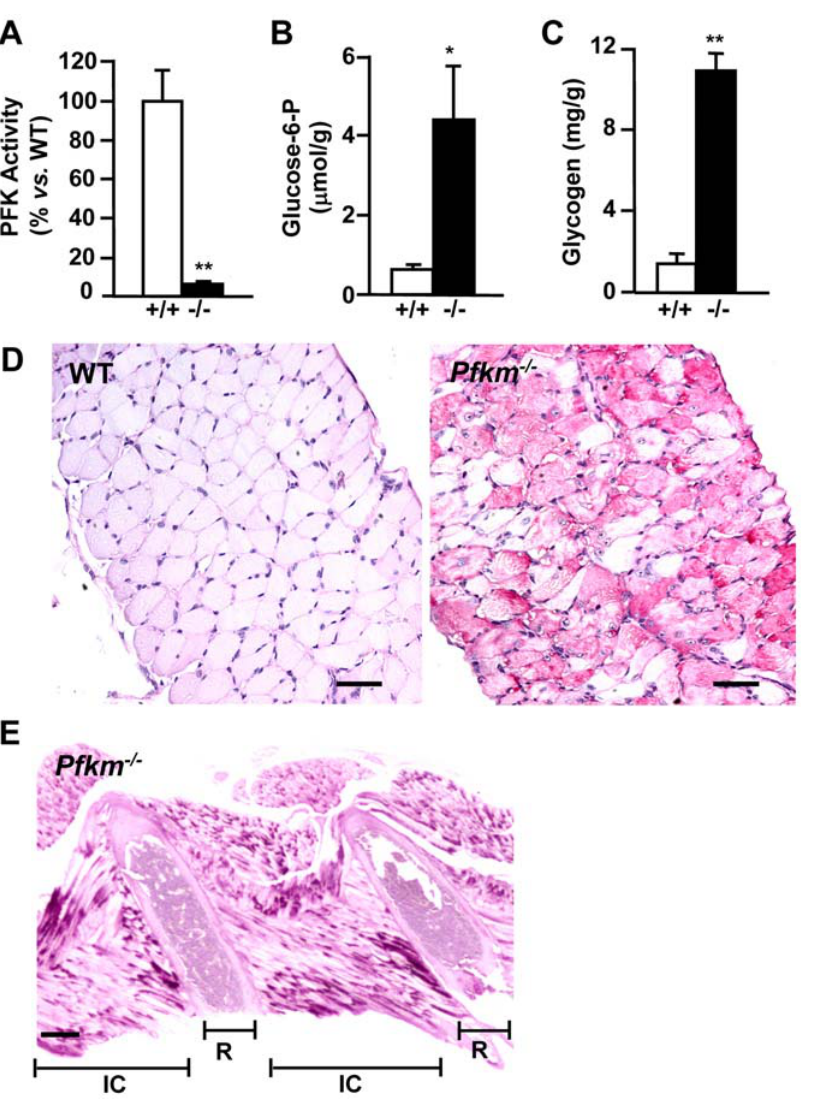
Figure 4. Effect of Pfkm ablation in diaphragm glucose metabolism and in respiratory muscle glycogen storage. (A) PFK activity was determined in diaphragm extracts as indicated in Materials and Methods. Basal PFK activity in wild-type mice was 26.5 6 4.2 U/g tissue. (B,C) Glucose- 6-phosphate (B) and glycogen concentrations (C) were determined in diaphragm perchloric extracts from wild-type ( + / + ) and Pfkm 2 / 2 ( 2 / 2 ) mice, as indicated in Materials and Methods. Results are mean 6 SEM of five mice per group. * P , 0.05, ** P , 0.01 vs. wild-type. (D,E) Glycogen storage evidenced by PAS staining in diaphragm sections (D) from wild-type (wt) and Pfkm 2 / 2 mice (scale bar 50 m m) and in intercostal muscle sections (E) from Pfkm 2 / 2 mice (scale bar 300 m m). IC, intercostal muscles; R,